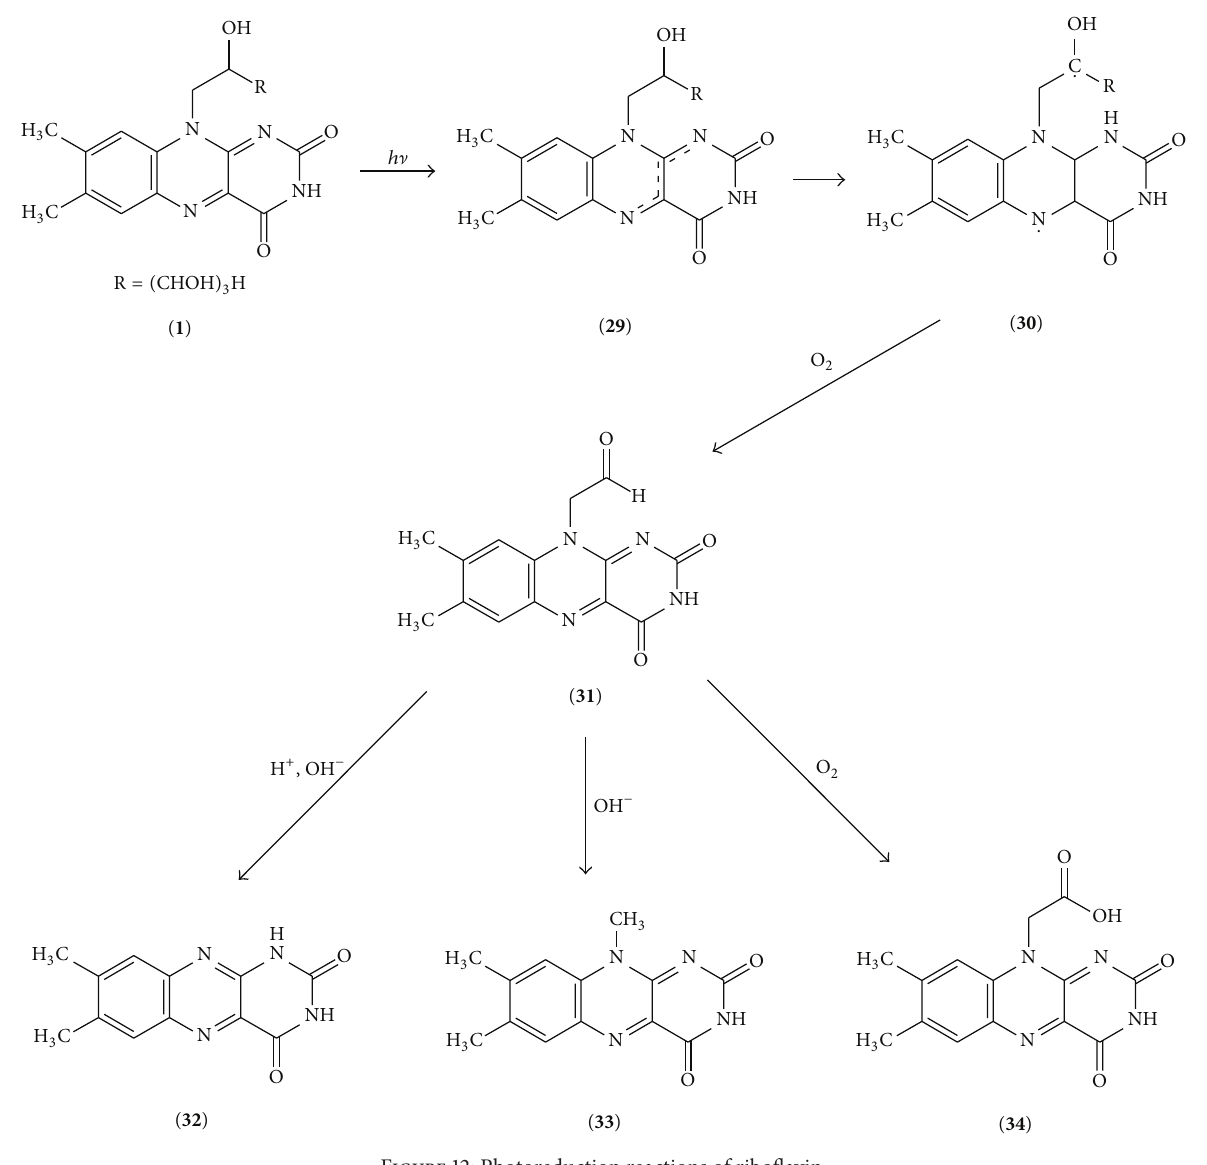
Figure 12: Photoreduction reactions of